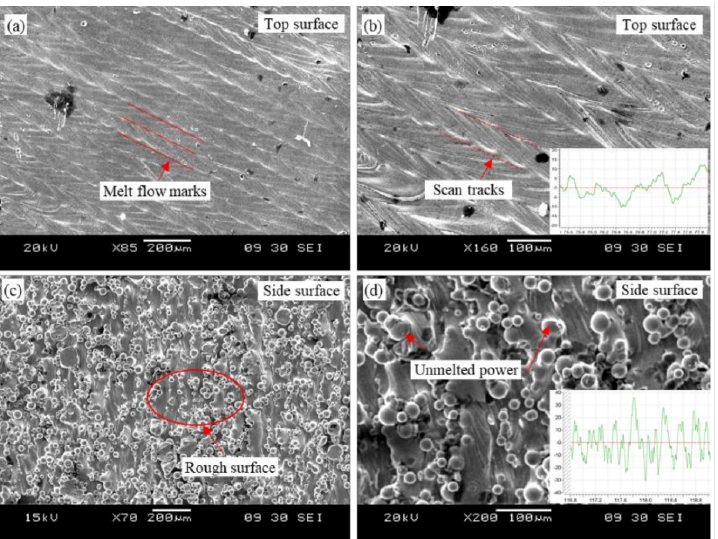
Figure 3. Surface morphology of SLM Ti6Al4V. ( a , b ) top surface. ( c , d ) side